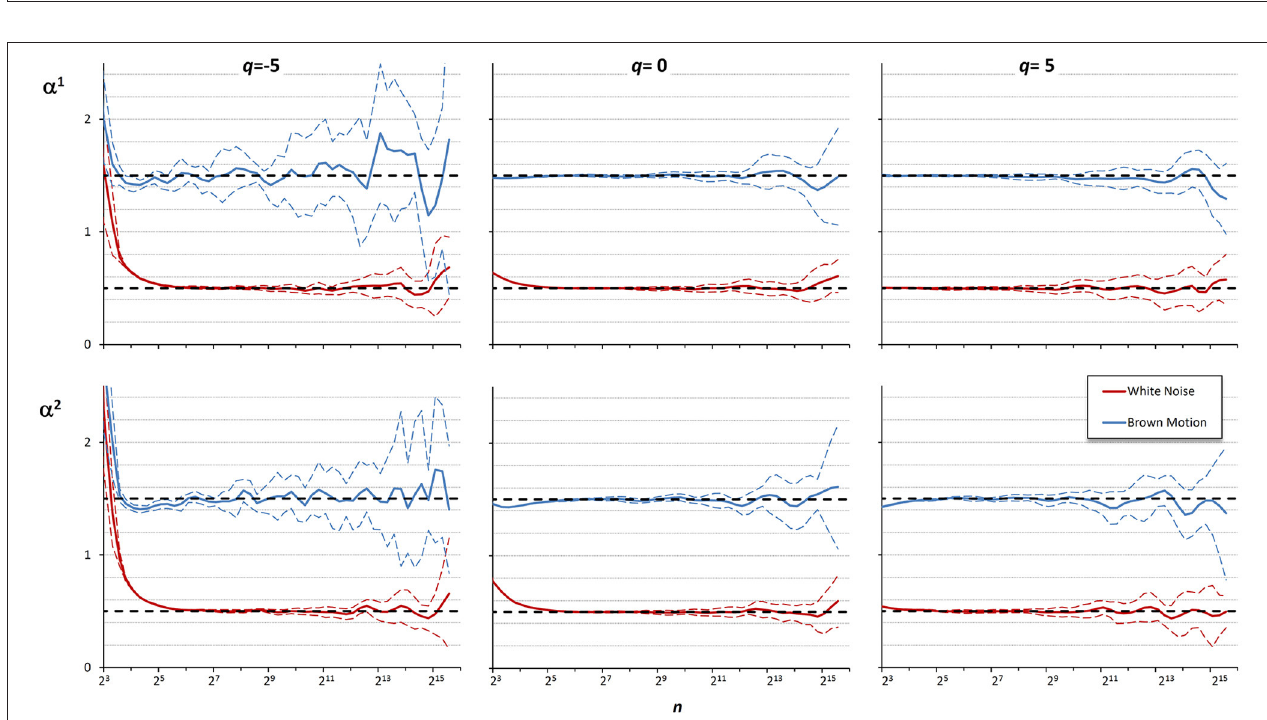
FIGURE 5 | Multifractal multiscale coefficients by DFA 1 , α 1 , and by DFA 2 , α 2 . Values as derivative of log F q (n) vs. log n with maximally overlapped blocks: mean ± SD for 10 white noises and 10 Brownian motions. Dashed horizontal lines represent the theoretical value for white noise ( = 0.5) or Brownian motion ( = 1.5).